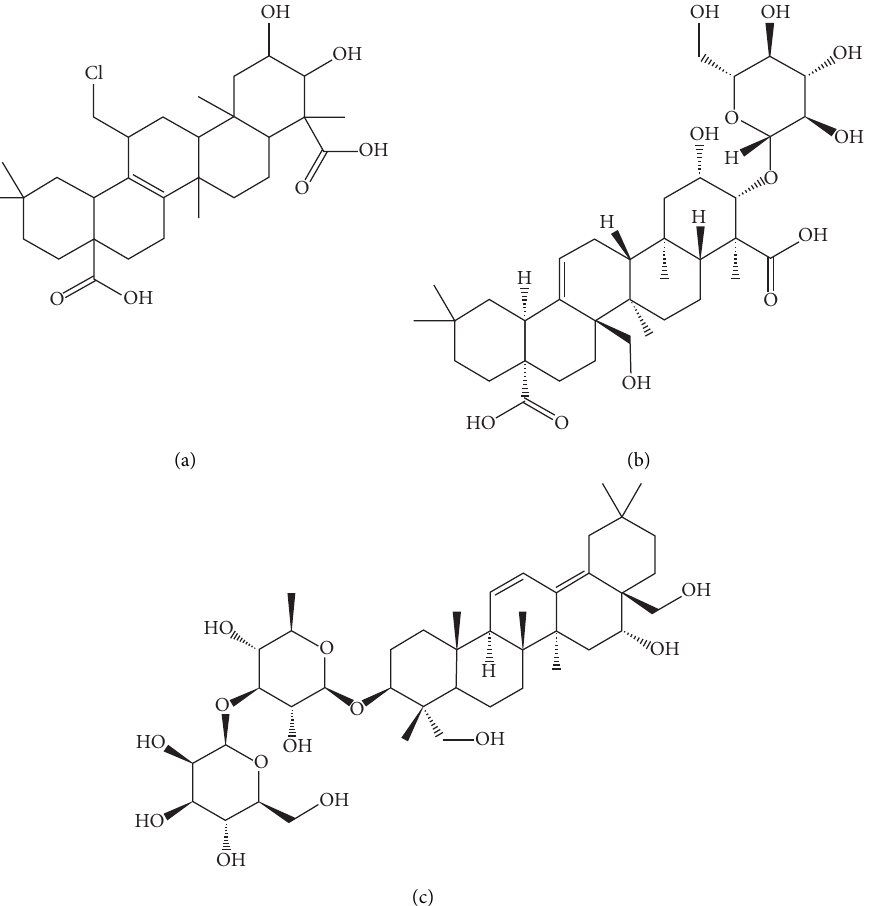
Figure 1: Chemical structure of senegenin (a), tenuifolin (b), and saikosaponin B2 (internal standard)